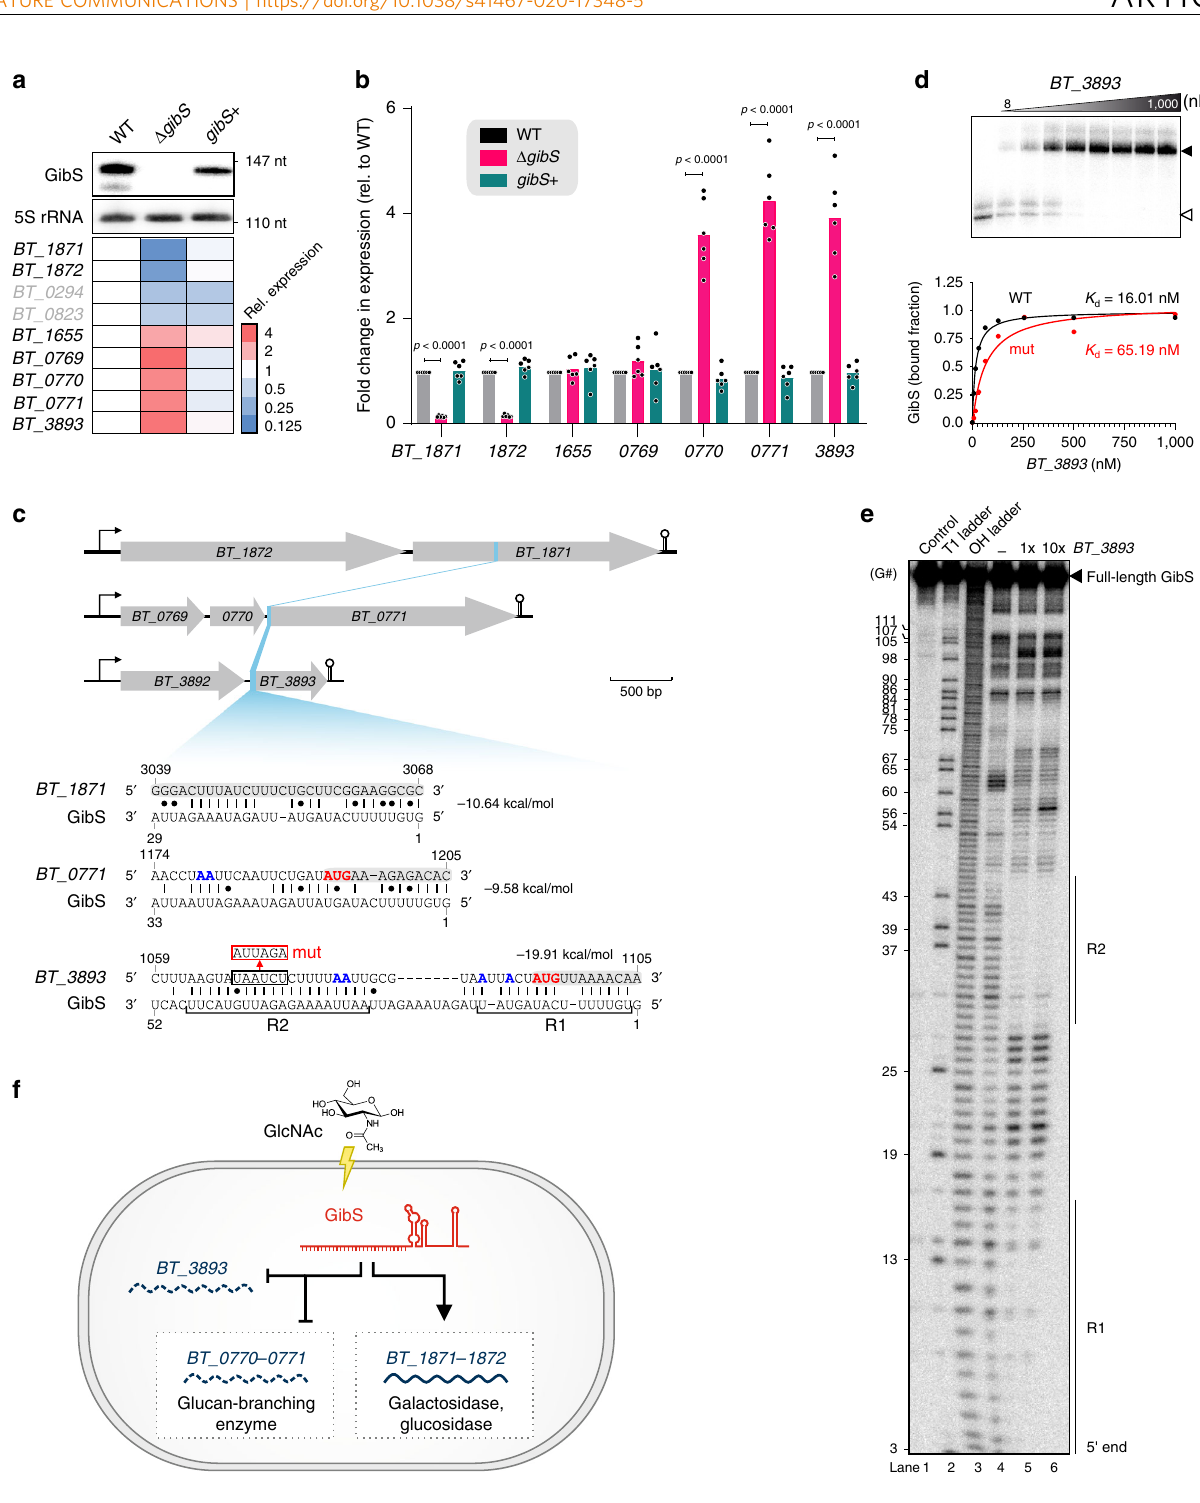
mRNA segments encompassing the assumed targeting sites.